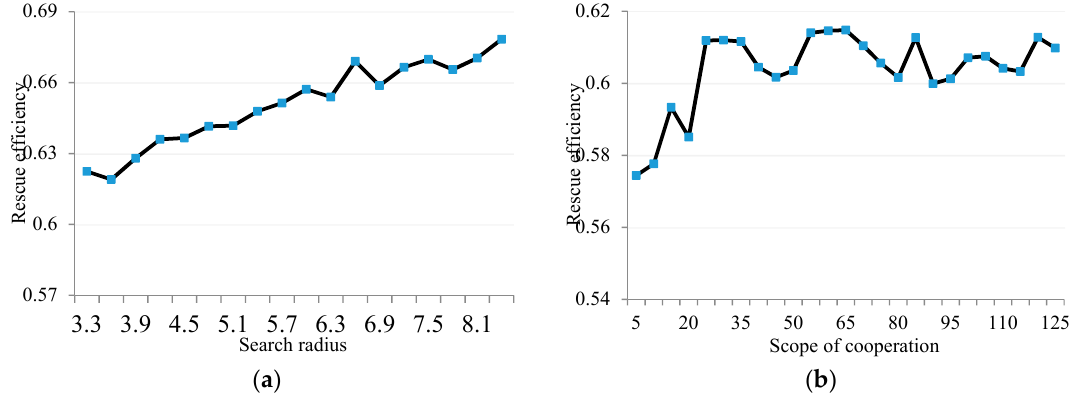
Figure 8. Robustness analysis of cooperative rescue plan. ( a ) Effect of search radius on rescue efficiency; ( b ) Effect of cooperation scope on rescue efficiency.